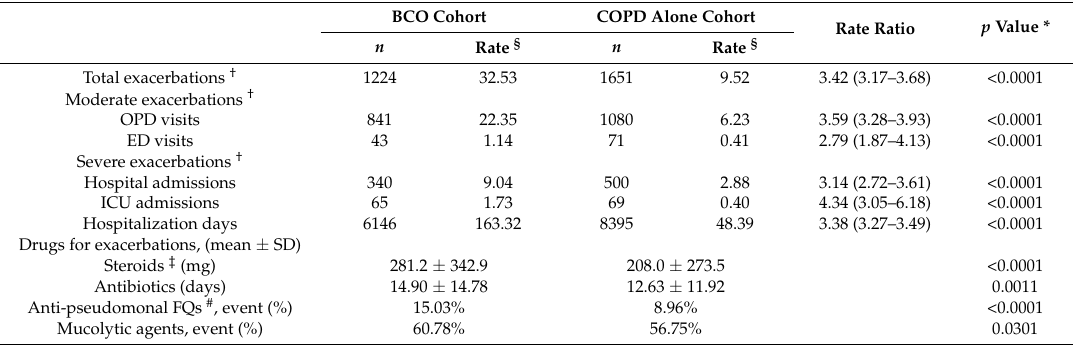
Table 2. Rate of COPD exacerbations in the bronchiectasis-COPD overlap (BCO) and COPD alone cohorts.